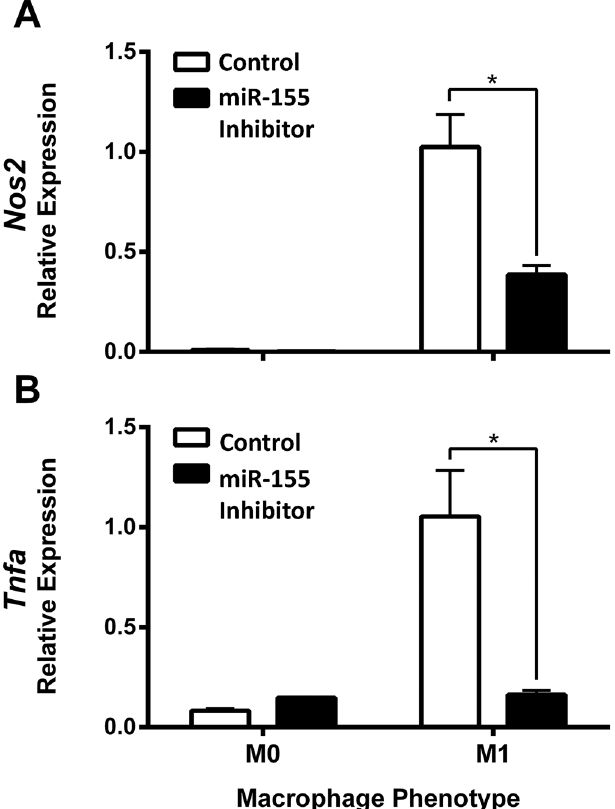
Fig 3. miR-155 inhibitor reduces M1 marker expression. ( A ) Inducible nitric oxide synthase ( Nos2 ) and ( B ) Tumor Necrosis Factor ( Tnfa ) expression was determined by Real-Time PCR in wild-type bone marrow- derived macrophages in vitro activated in M0 or M1 conditions for 24 hours and transfected with a scrambled (n = 3) or a miR-155 oligonucleotide inhibitor (n = 3 – 4). Gene expression is expressed as a percentage +/- SEM of the scrambled M1 condition. Unpaired t-test, * p < 0.05. Data reproduced in two independent